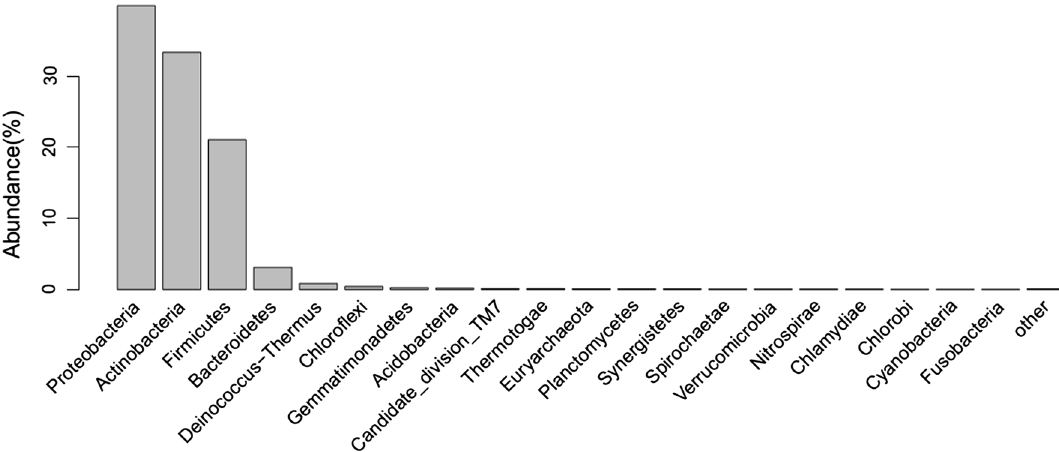
Fig. 4 Community abundance histogram of gate level in reaction